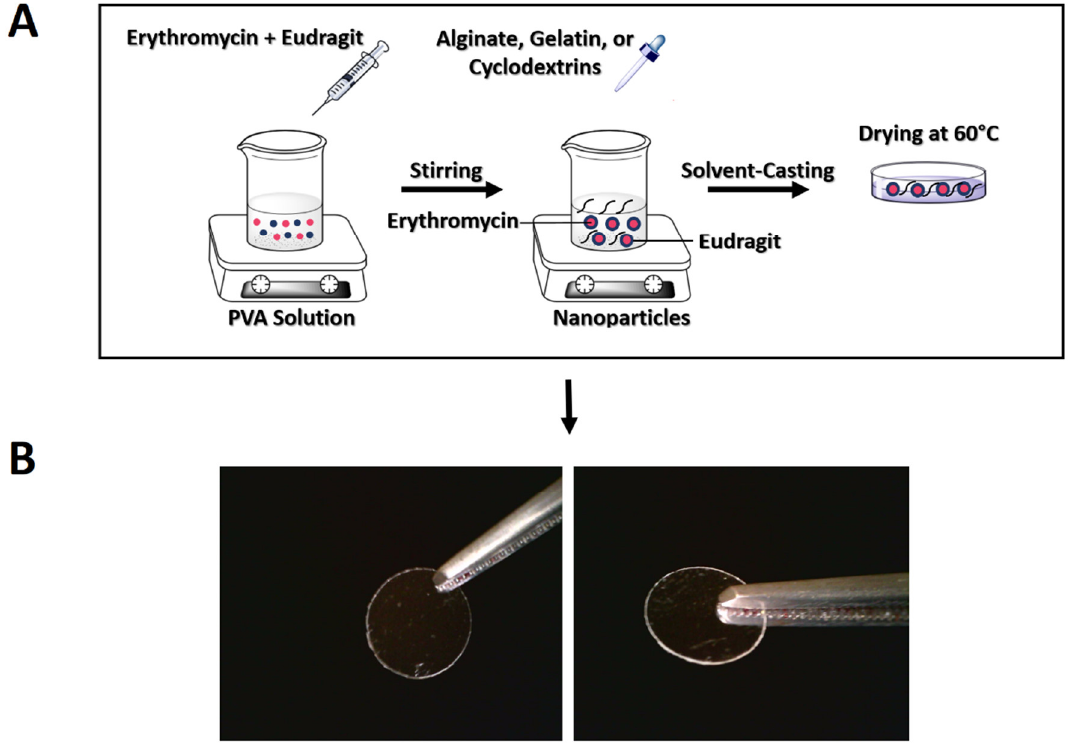
Figure 1. A schematic representation of the polymeric nanoparticle (PNP)-loaded film preparation procedure ( A ) visual appearance of nanoparticles-impregnated polymeric film insert ( B ).